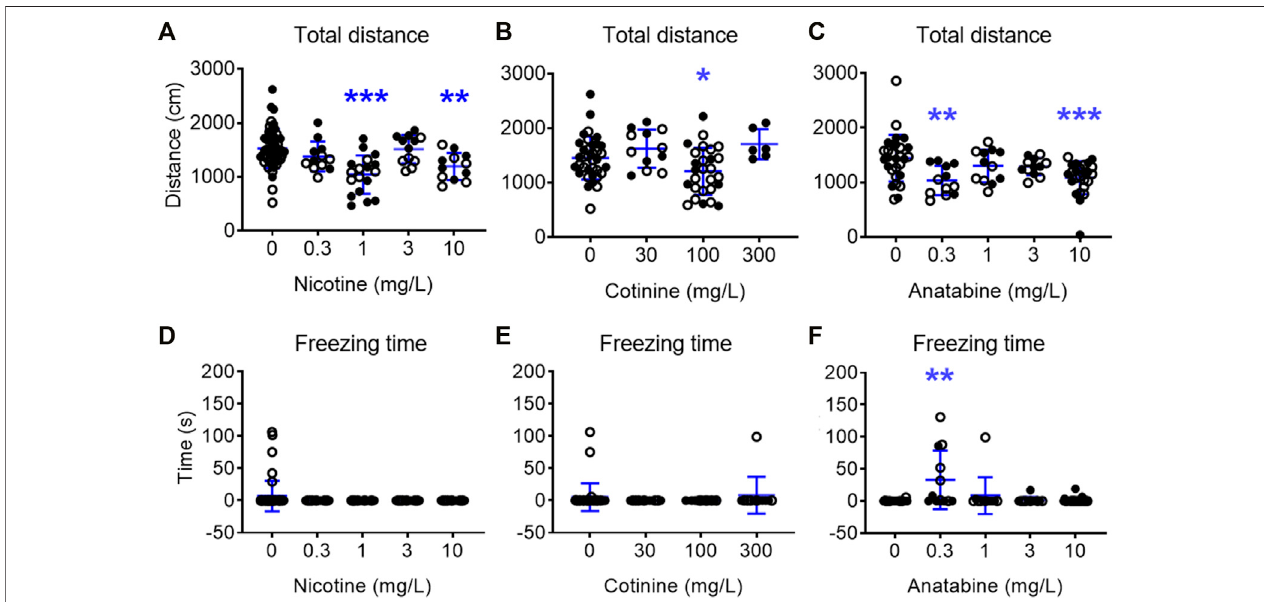
FIGURE3| Effectsofalkaloidsongeneralmovementinzebra fi sh.Totaldistancetraveledover5 mintestperiodfor (A) nicotine, (B) cotinine,and (C) anatabineand freezingtimefor (D) nicotine, (E) cotinine,and (F) anatabinearepresented.Aslightreductioninthemovementwasdetectedfor fi shexposedtonicotineat1and10 mg/ L, cotinine at 100 mg/L, and anatabine at 0.3 and 10 mg/L. Freezing time was only increased by 0.3 mg/L anatabine treatment. Each individual circle represent one zebra fi sh. Solid circles = males; open circles = females; n = 12 – 36; * p < 0.05 and *** p < Data are presented as mean ± S.D.